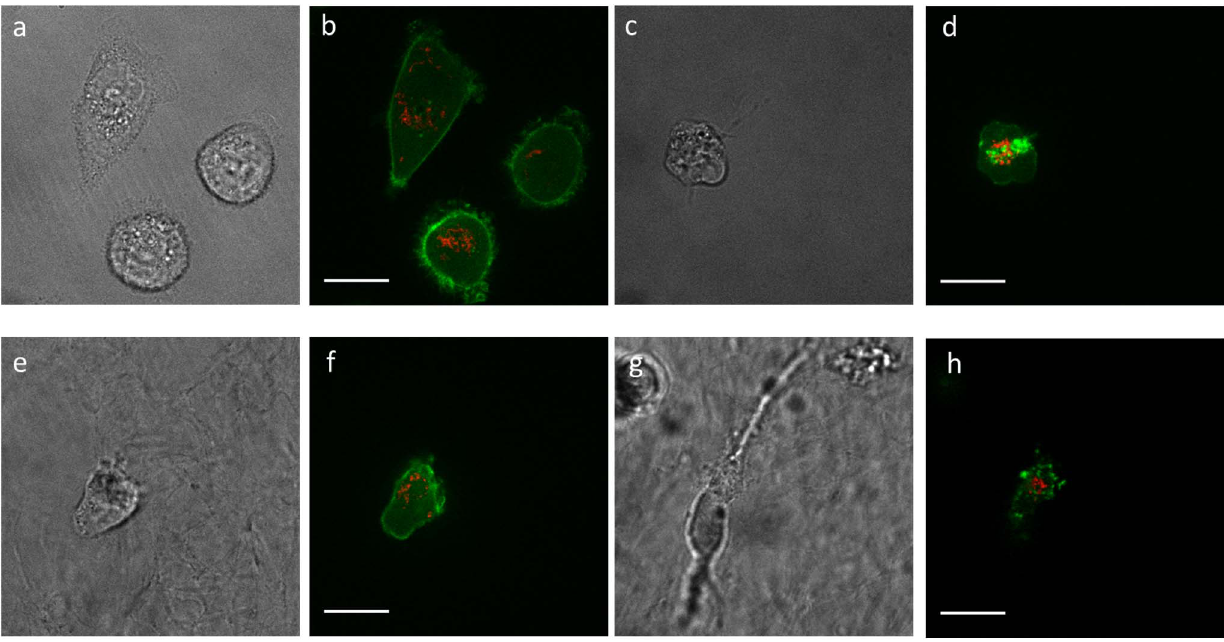
Figure 5. Images of MDA-MB-231 cells in 2D and 3D with and without Cytochalasin D treatment. a–h) Bright field and fluorescence images of (a,b) untreated cells in 2D, (c,d) Cytochalasin D treated cells in 2D, (e,f) untreated cells in 3D, and (g,h) Cytochalasin D treated cells in 3D. Green and red represent actin and mitochondria, respectively. The scale bar is 20 m m.